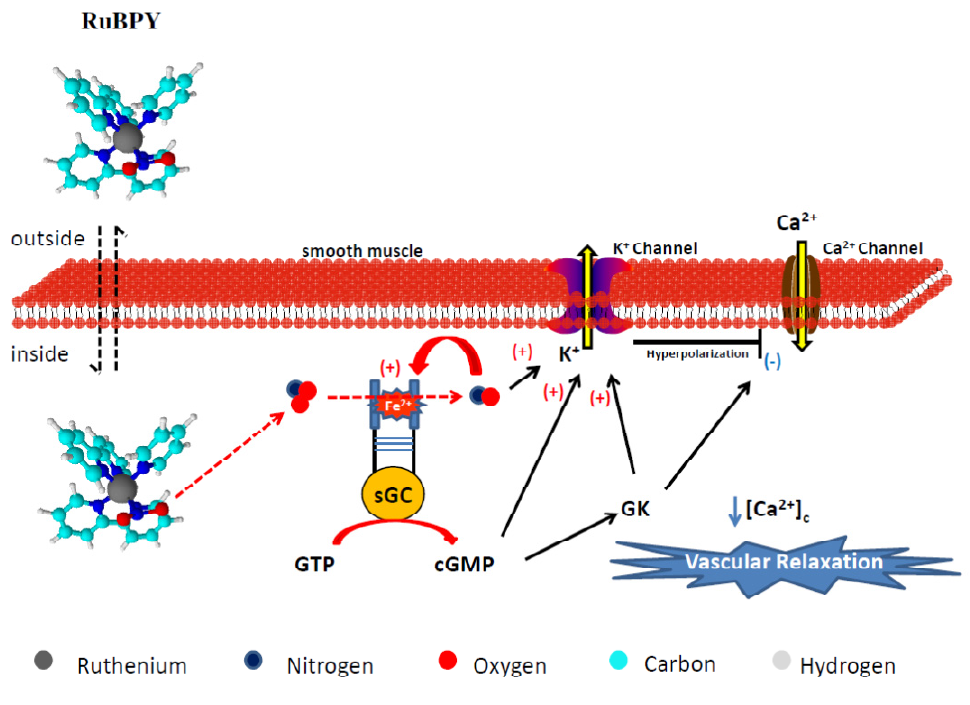
Figure 7. Proposed nitric oxide release and vasodilation mechanism elicited by cis - [RuCl(bpy) (py)NO ](PF ) (RuBPY). The colored circles represent atoms in the chemical 2 2 6 structure. Legend: sGC = soluble guanylyl cyclase, GK = G Kinase Protein, Ca 2+ = = cytosolic calcium calcium, K + = potassium, [Ca 2+ ] c